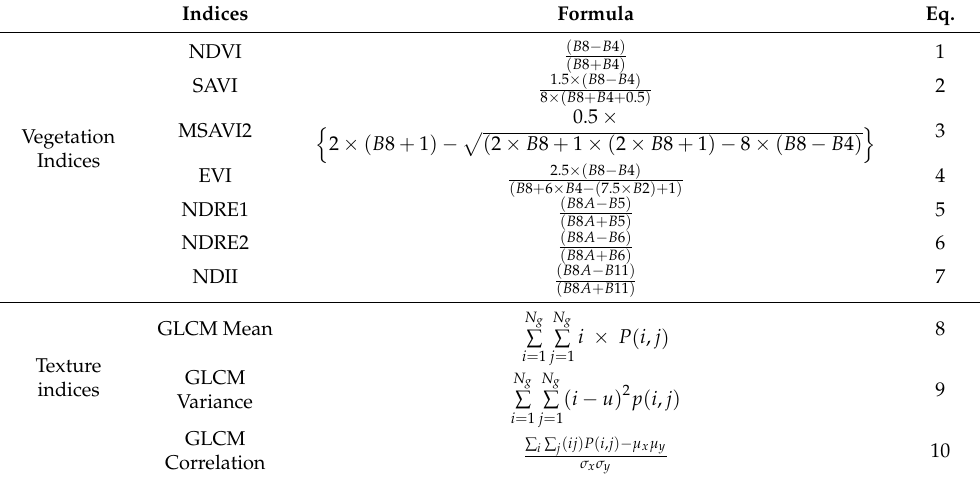
Table 2. Vegetation and texture